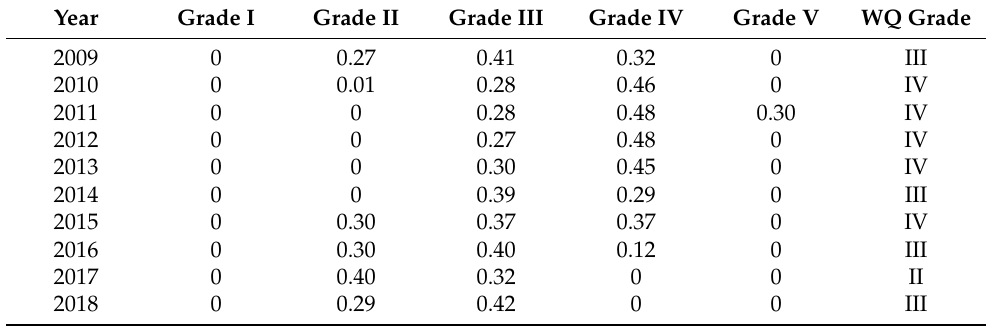
Table A15. Fuzzy integrated evaluation results of Wangjiangjing Station in Jiaxing, Zhejiang.